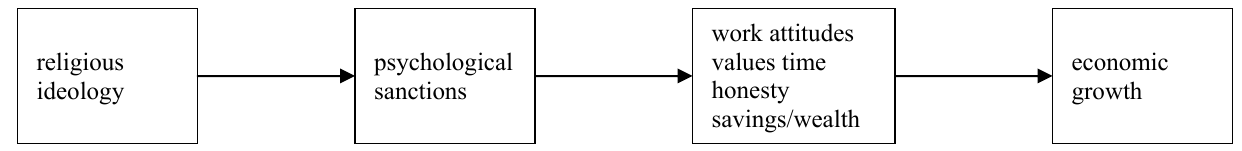
Figure 1: Diagram showing the relationship of variables in Weber’s protestant ethic In Weber’s (1958:155-183) chapter on asceticism and the spirit of capitalism, he discusses the connection between the fundamental religious ideas of Protestantism and its maxims for everyday economic